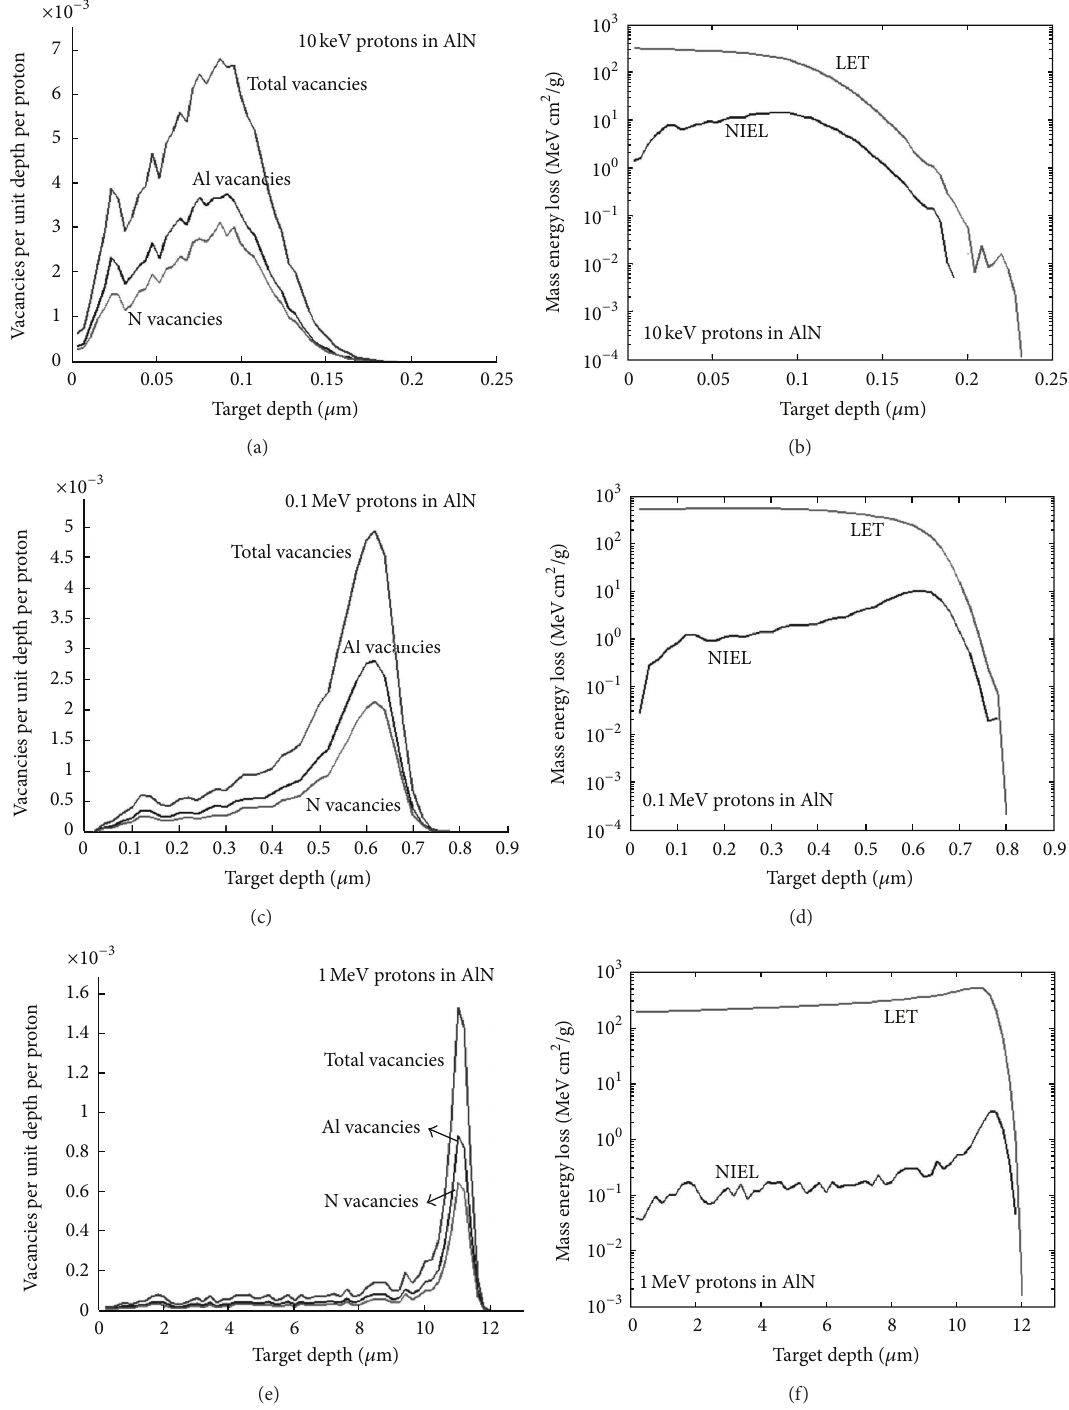
Figure 2: Plots of vacancy concentrations and mass energy losses (LET and NIEL divided by material density) along the depth of an aluminium nitride (AlN) insulating film. Results were obtained from simulations of 10 4 proton histories, which included subcascades of recoiling